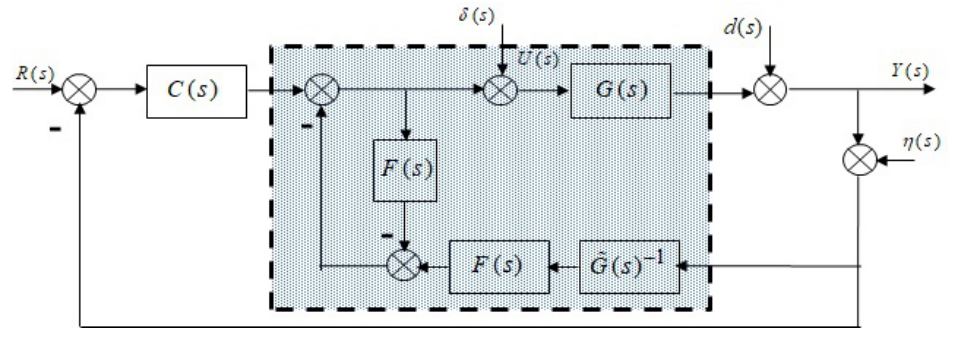
Figure 5. Disturbance observer control